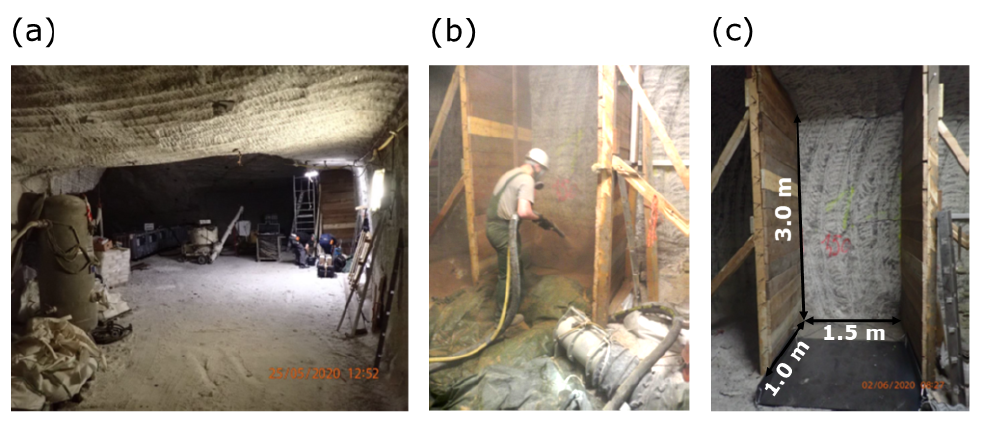
Figure 1. Impressions from shotcrete experiments at Teutschenthal mine: ( a ) experimental under- ground site, ( b ) during shotcrete procedure at a shotcrete box, ( c ) preparation of a shotcrete box. Table 1. Overview of the presented ultrasonic investigations at shotcrete experimental sites.